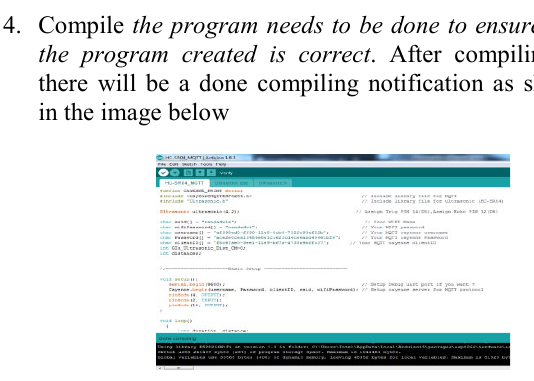
Figure 10. Selection of the Arduino Board and Port